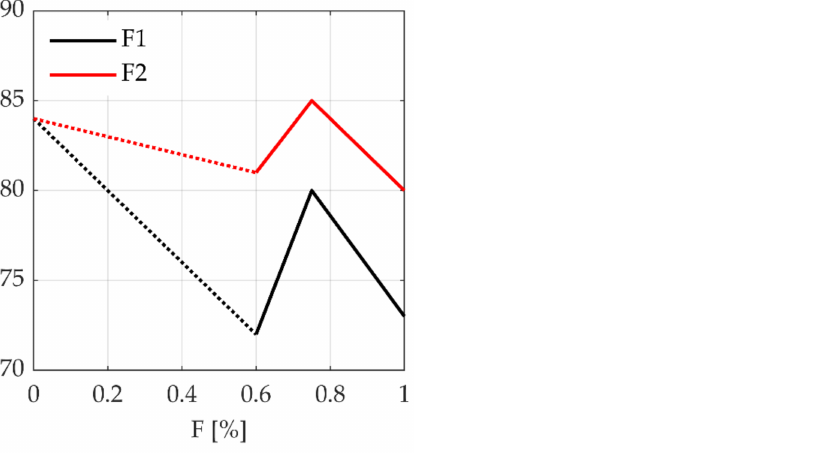
Figure 12. Slump test results for the fibers, F1 and F2, by varying the fiber content, F